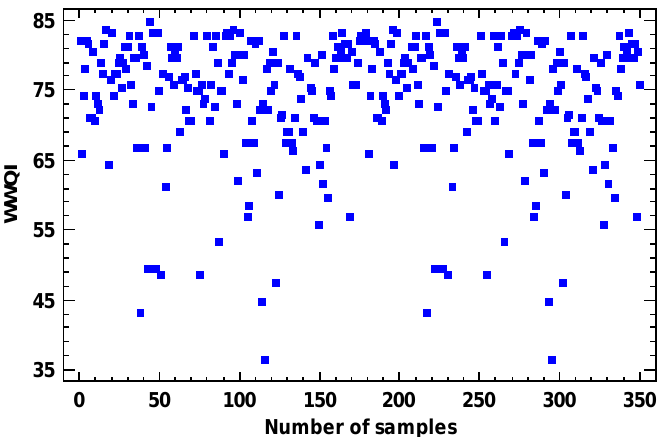
Figure 2. Wastewater Quality Index variation.